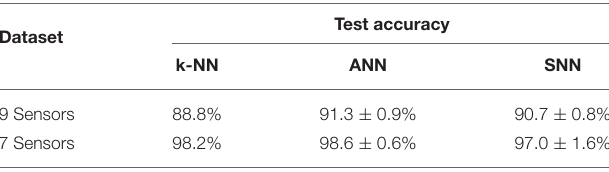
TABLE 4 | Average classification performance of ANN and converted SNN models on the MicroBeTa dataset.